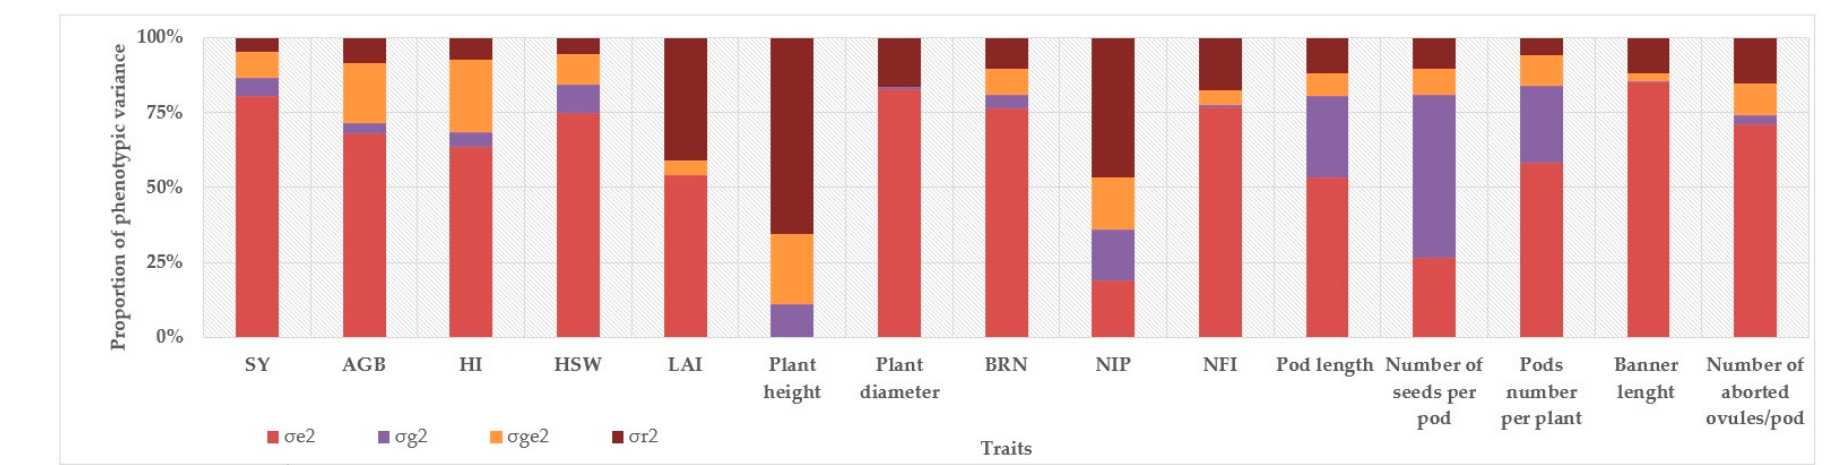
Table 2. Likelihood Ratio Test and Estimated Variance Components of 15 Faba Bean Landraces Evaluated for Three Consecutive Growing Seasons .